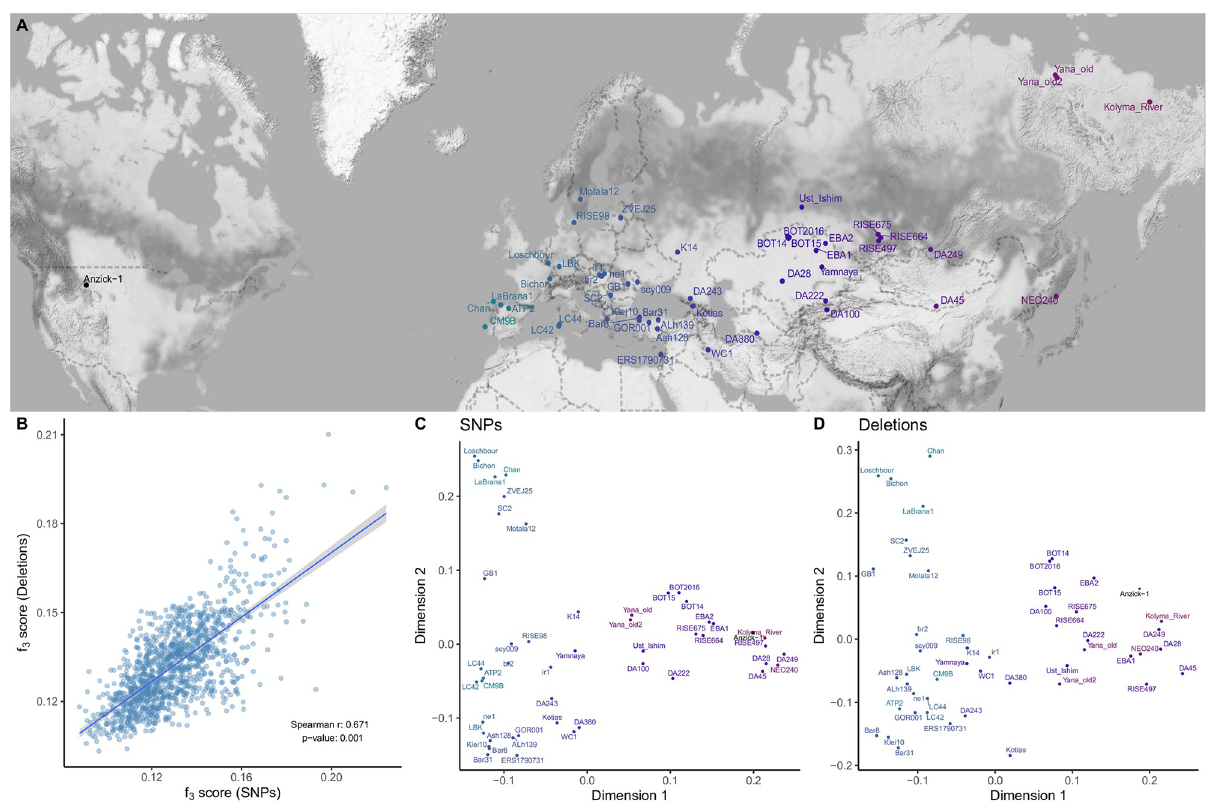
Fig 5. Deletion vs. SNP diversity. (A) Geographic locations of the 50 ancient individuals used in the analyses. (B) Comparison of genetic distances calculated between pairs of genomes using SNPs and deletions. We calculated the Spearman correlation coefficient between two matrices and then calculated the Mantel test p-value using the “mantel” function in R package “vegan” (v2.5–7). (C) and (D) represent multidimensional scaling plots that summarize outgroup- f 3 statistics calculated across all pairs among the 56 ancient individuals using SNPs and deletions, respectively. To create the map, we used Stamen map tiles (Map tiles by Stamen Design, under CC BY 3.0. Data by OpenStreetMap, under ODbL) with “ggmap” [92] R package. We added points and texts to plots by using “ggplot2” [93] and its extension “ggrepel”